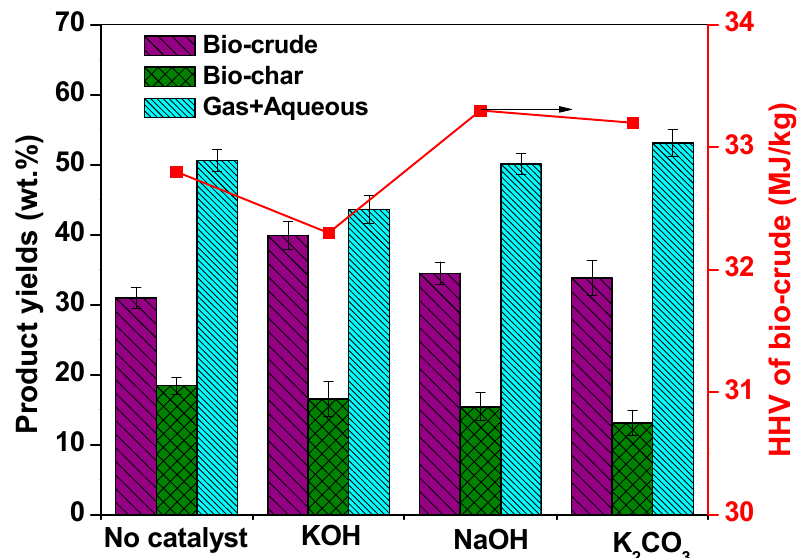
Figure 4. E ff ect of alkali catalysts on product yields and HHV of bio-crude at 300 ◦ C, 60 min, rice Figure 4. Effect of alkali catalysts on product yields and HHV of bio-crude at 300 °C, 60 min, rice straw:solvent ratio of 1:10 wt. / wt., catalyst quantity of 5 wt.%, and 50:50 (vol.% / vol.%) straw:solvent ratio of 1:10 wt./wt., catalyst quantity of 5 wt.%, and 50:50 (vol.%/vol.%) methanol:water.